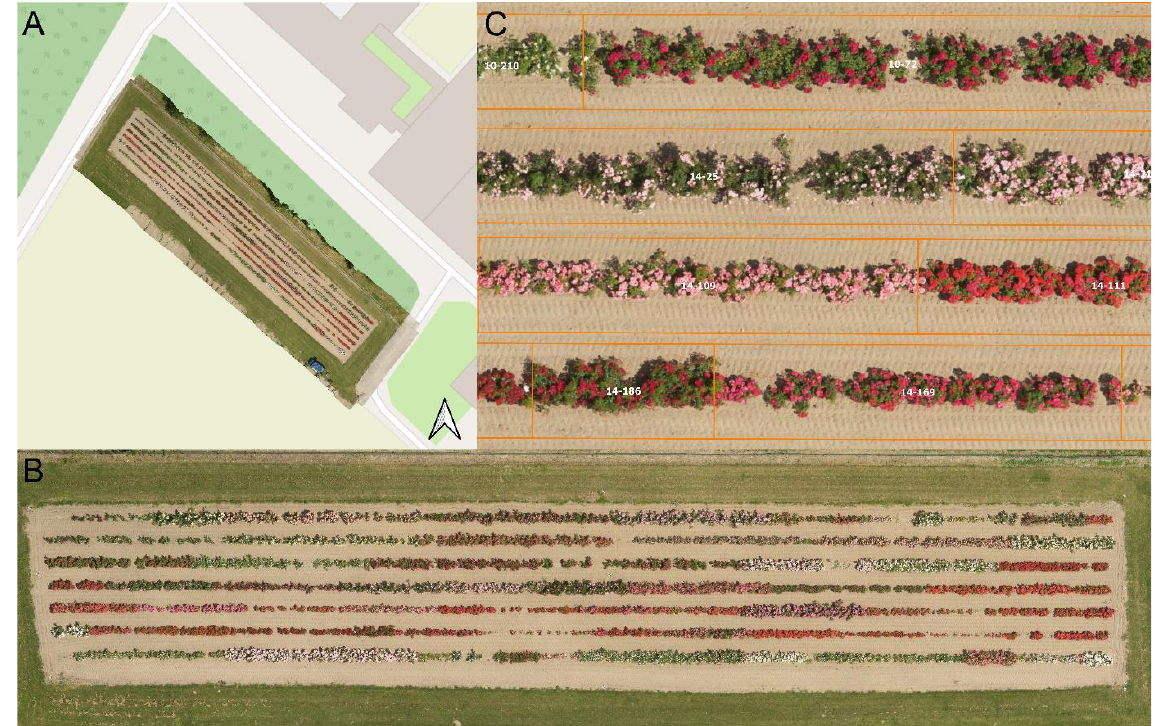
Figure 2. ( A ) Location of the rose trial; ( B ) Orthophoto of the entire trial based on a UAV flight done on 1 July 2019; ( C ) detail of a part of the trial with polygons defining the different genotypes. Table 1. Overview of the morphological characteristics evaluated for Sarcococca and Rosa . Case